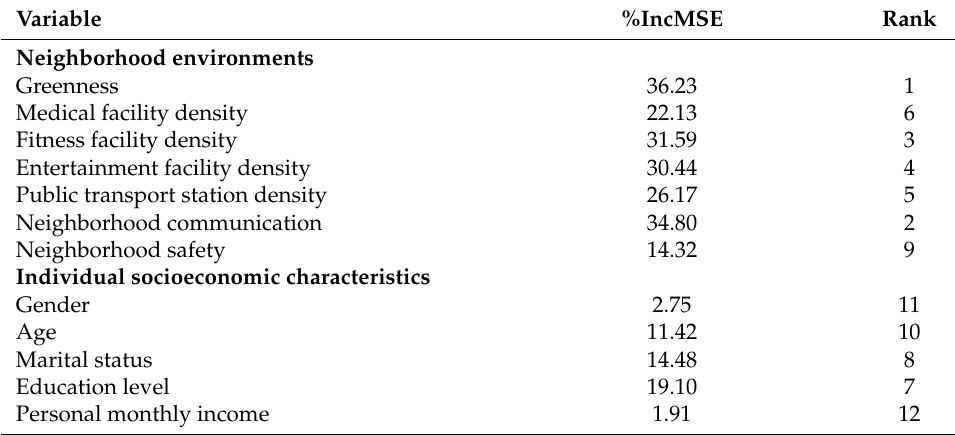
Table 2. Importance of variables that affect mental